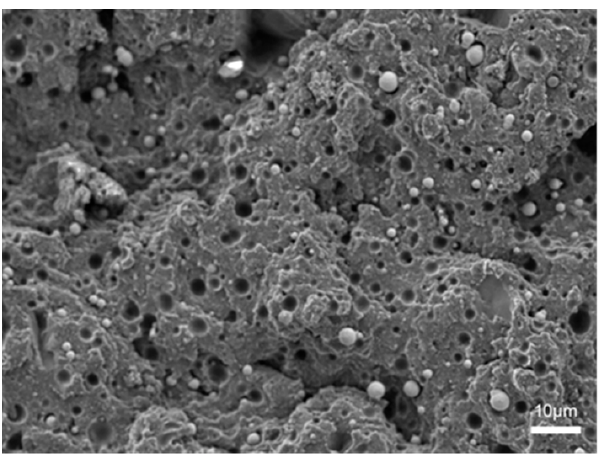
Figure 7. SEM image of tensile fracture surface of MREs.